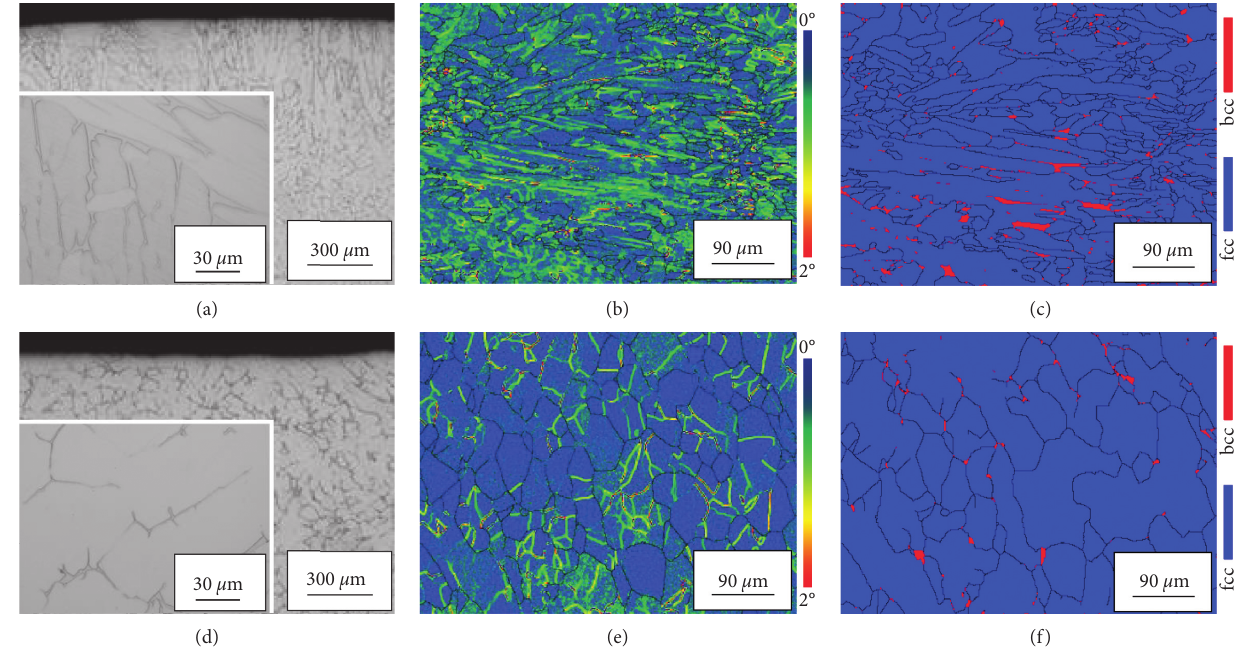
Figure 7: Cross section structure and EBSD analysis results: (a) cross section structure of sample A; (b) LocMis map of sample A; (c) phase map of sample A; (d) cross section structure of sample N; (e) LocMis map of sample N; (f) phase map of sample